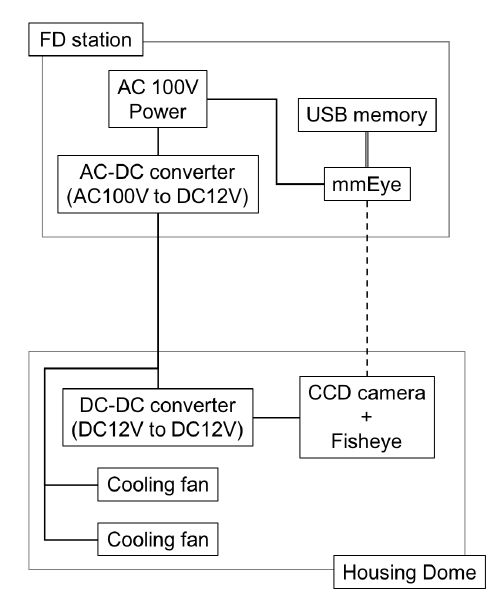
Figure 3: Diagram of the Cloud monitoring system. The black solid lines are power line. The black dashed line is signal line. Black double lines are physical connection.